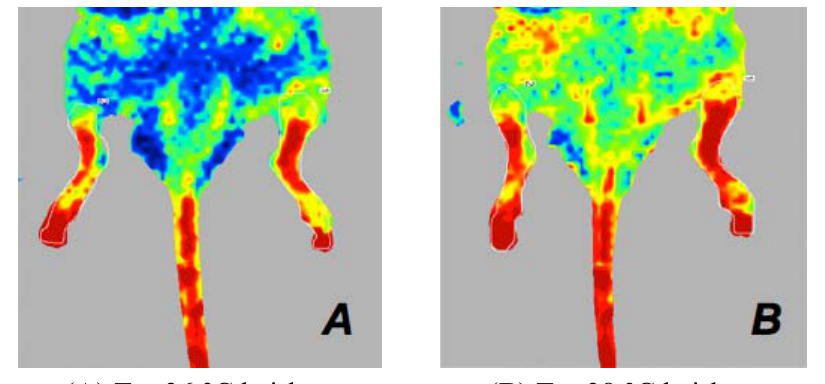
Figure 7. Laser Doppler images of the hind limbs of mice in the presence or absence of hair when the mouse is positioned in ventral decubitus position. Mice anaesthetised with intraperitoneal drugs, both at 36 °C and 38 °C, with ARD depilation ( A , B ) have higher perfusion values than those found under similar experimental conditions but with ARC depilation ( C , D